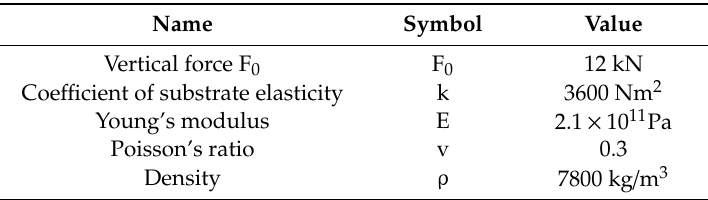
Table 1. Switch point parameters used in